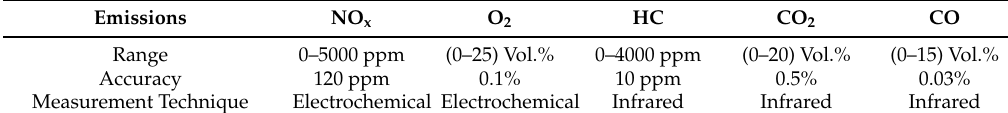
Table 3. Technical specification of emission analyzer.